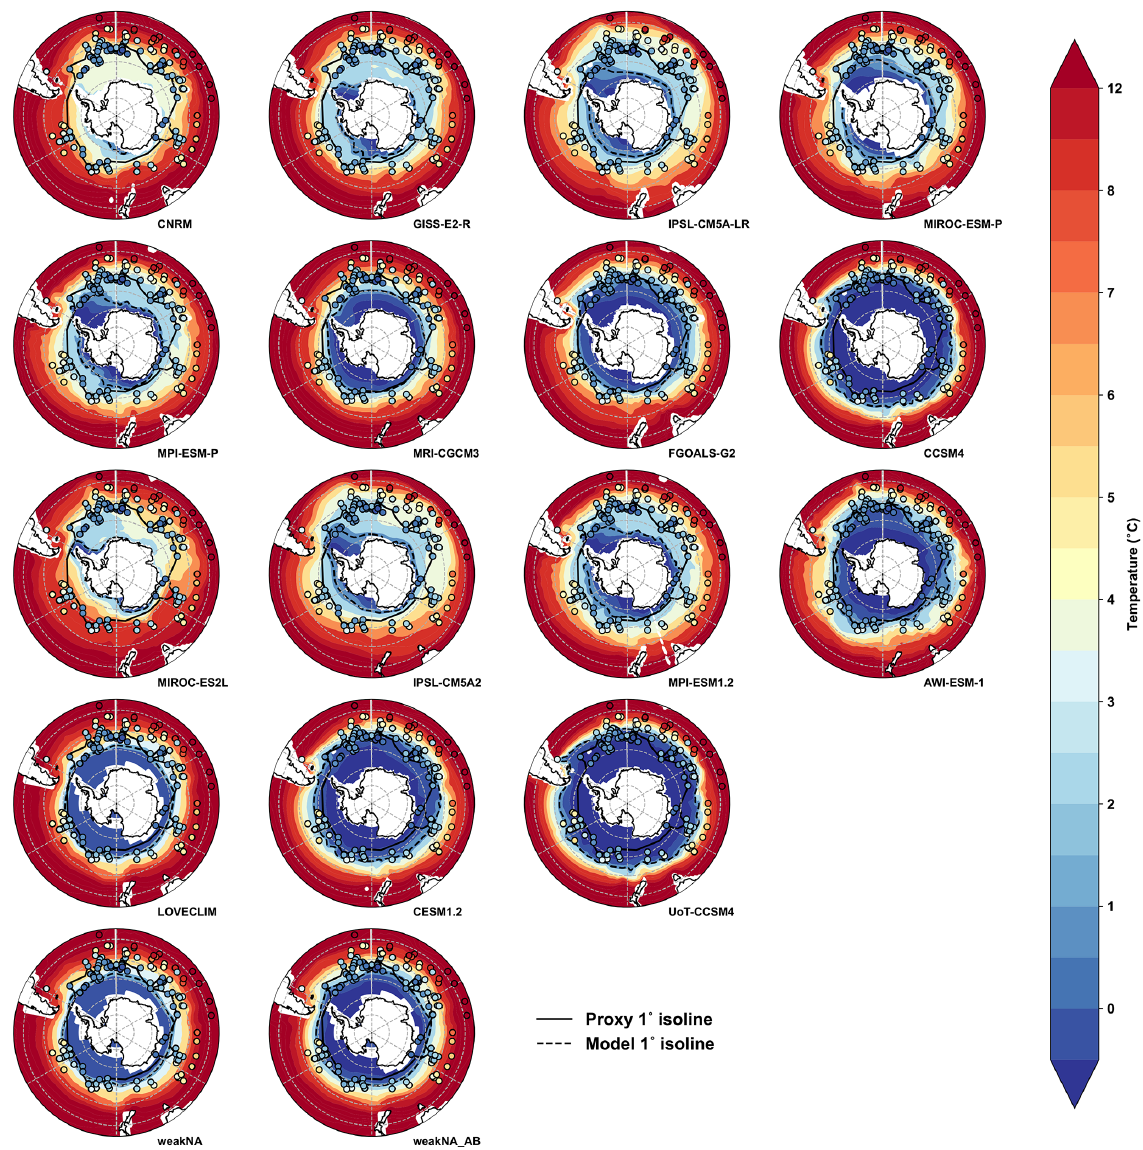
Figure 3. PMIP3, PMIP4 and LOVECLIM austral summer SST (shading) with SST proxy data overlain (filled circles). Fill color inside each SST reconstruction data point represents paleo SSTs at each location. Each model’s 1 ◦ C isoline (dotted black line) is compared to the proxy SST data 1 ◦ C isoline (solid black